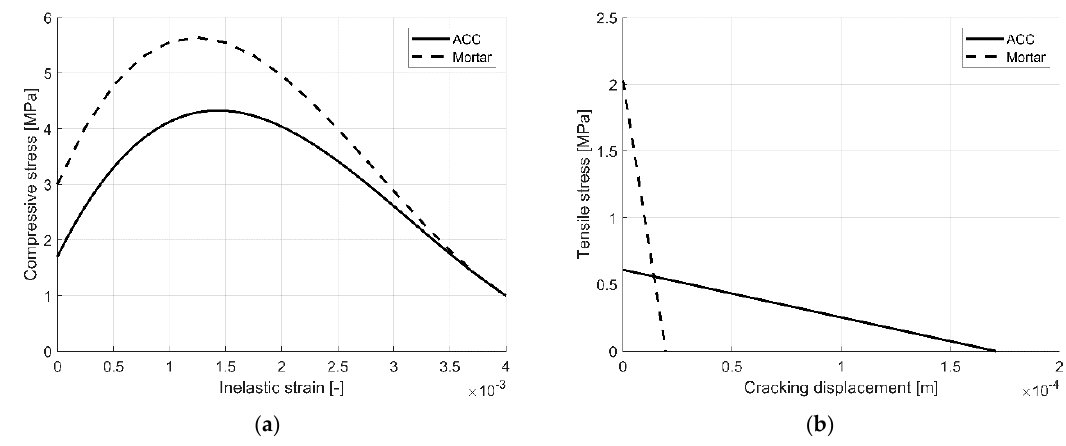
Figure 8. Material model of AAC and mortar [44]: ( a ) Compressive stress–inelastic strain curves (compressive behaviour); ( b ) Tensile stress–cracking displacement (tensile behaviour).